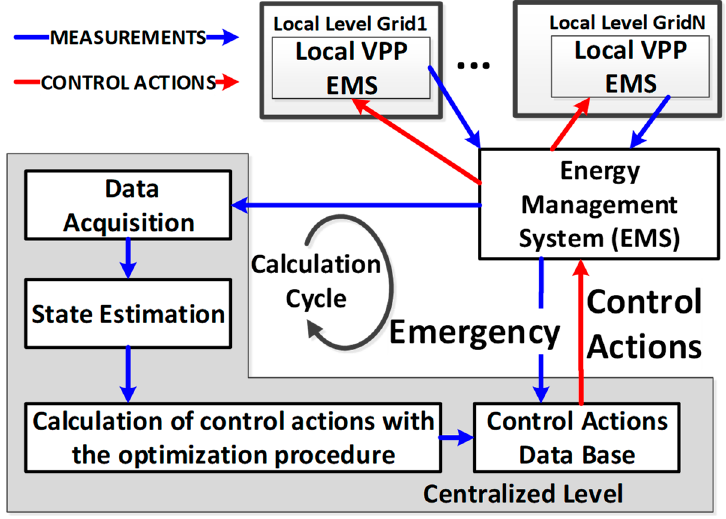
Figure 4. Hybrid network emergency control calculation cycle.